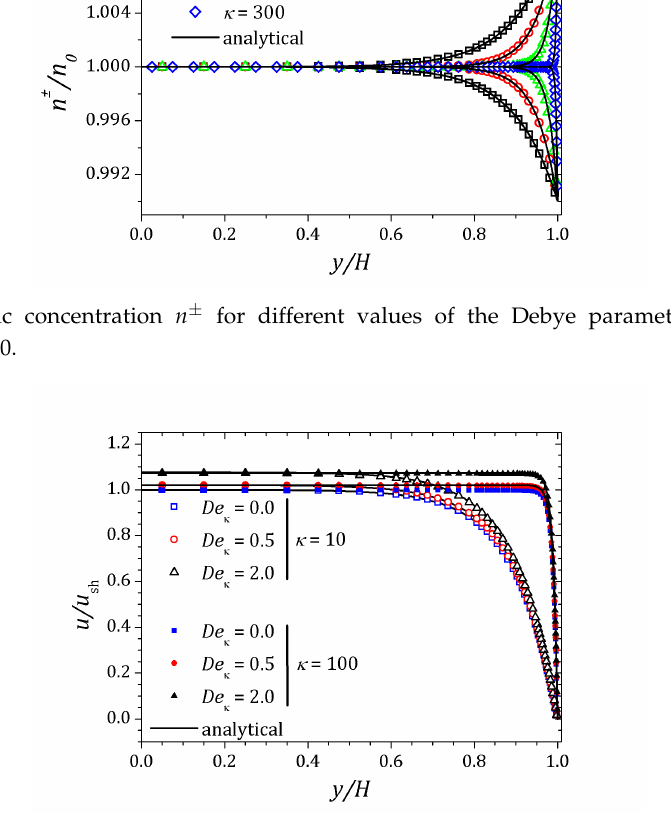
Figure 8. Velocity profiles to the full PTT model for κ = 10 and 100. Results for ε = ξ = 0.01, varying the Deborah number De κ = 0,0.5 e